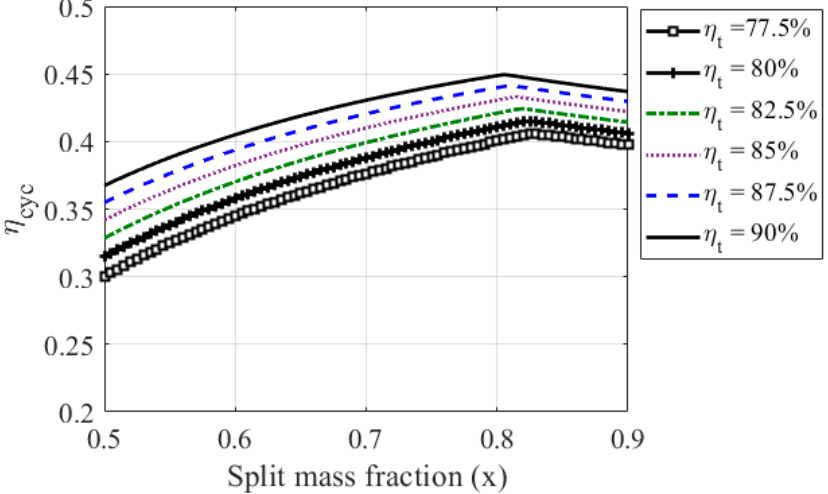
Figure 7. Impact of the turbine’s performance on the cycle’s efficiency.